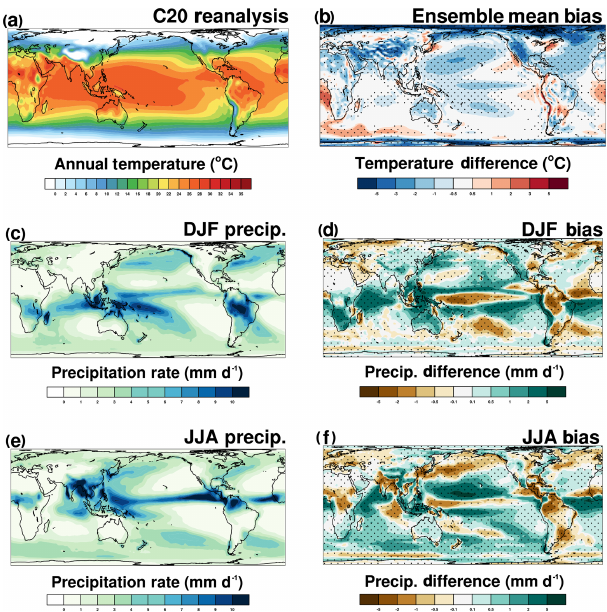
Figure 3. Comparison of the CMIP6 ensemble to observations. (a) The annual mean surface temperatures in the C20 reanalysis (Compo et al., 2011) between 1881 and 1900. (b) The ensemble mean difference in annual surface air temperature from the C20 re- analysis within the piControl simulations. Ability of the ensemble to simulate the seasonal cycle of precipitation for the present day. (c, e) The precipitation climatology seen in the GPCP (Adler et al., 2003) observational dataset between 1971 and 2000 for DJF and JJA respectively. (d, f) The ensemble mean difference in seasonal precipitation from GPCP within the piControl simulations for DJF and JJA respectively. Stippling indicates that two-thirds of the mod- els agree on the sign of the